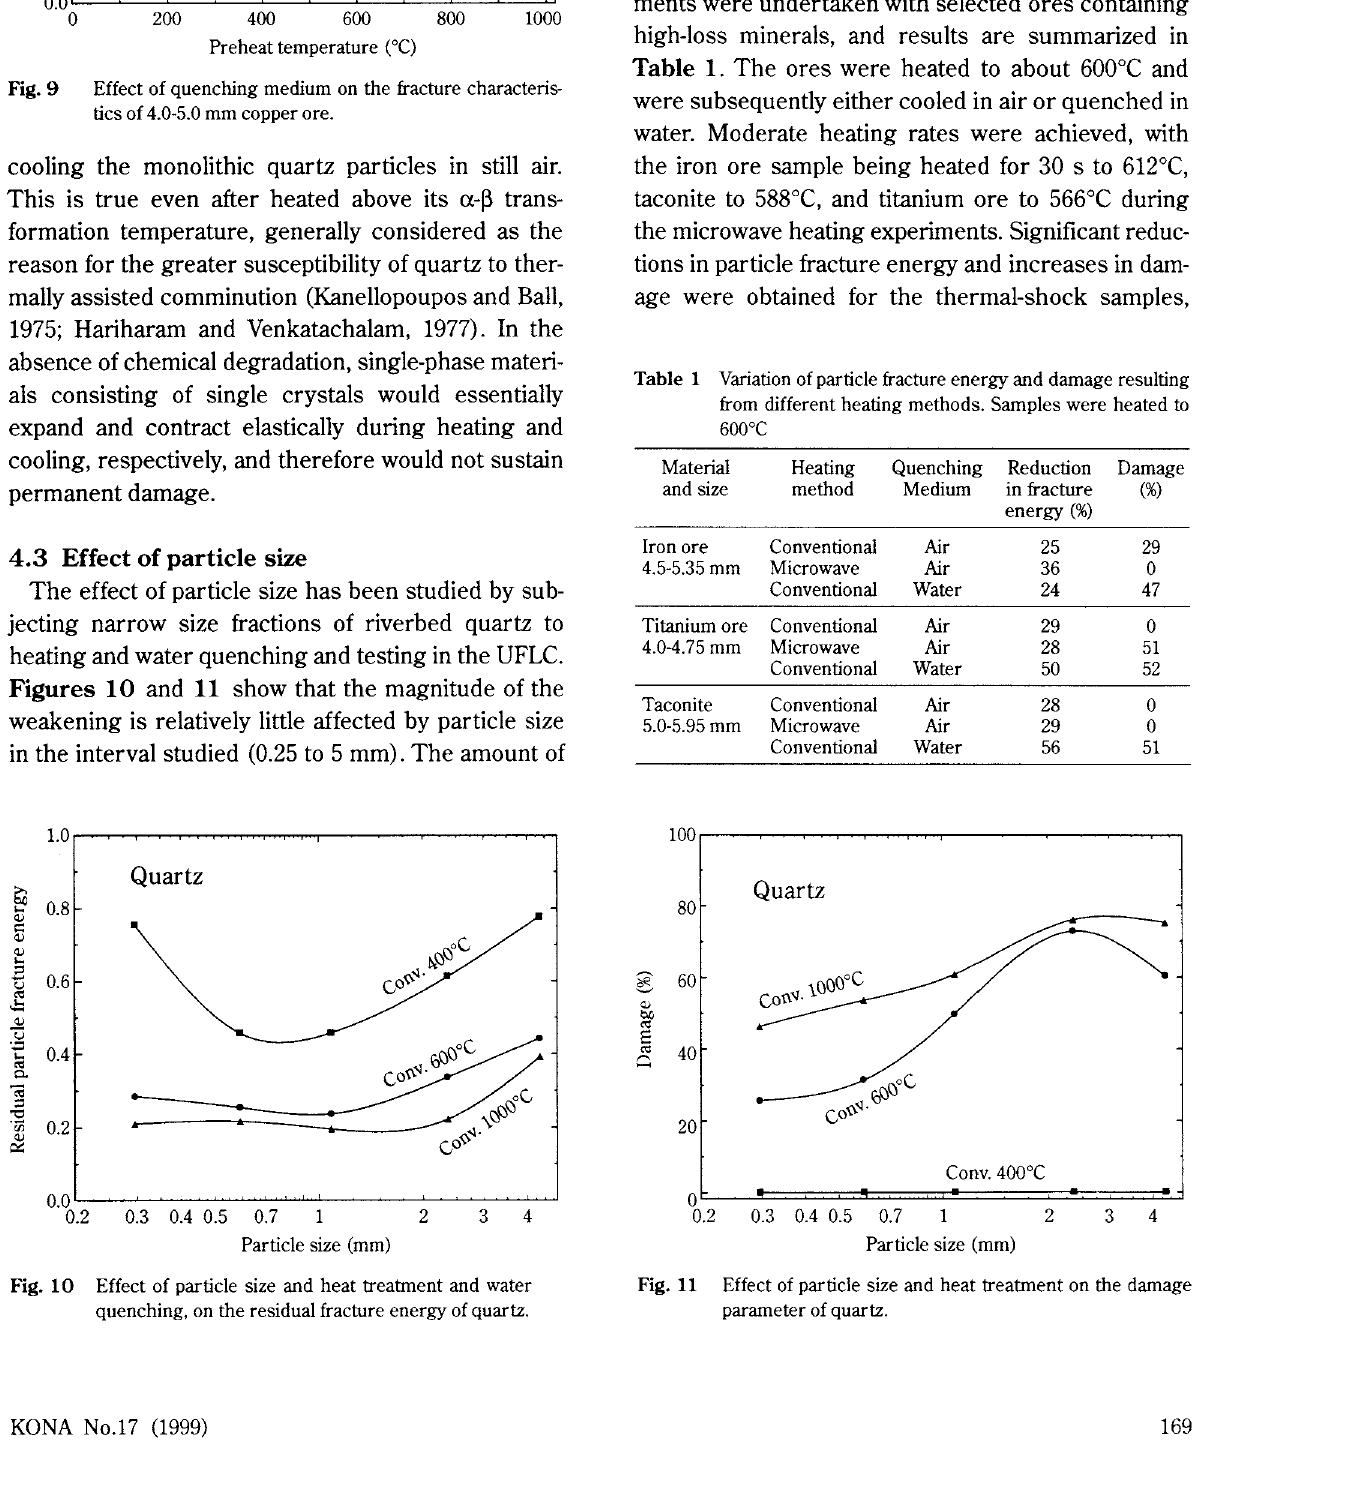
KONA No.17 (1999)